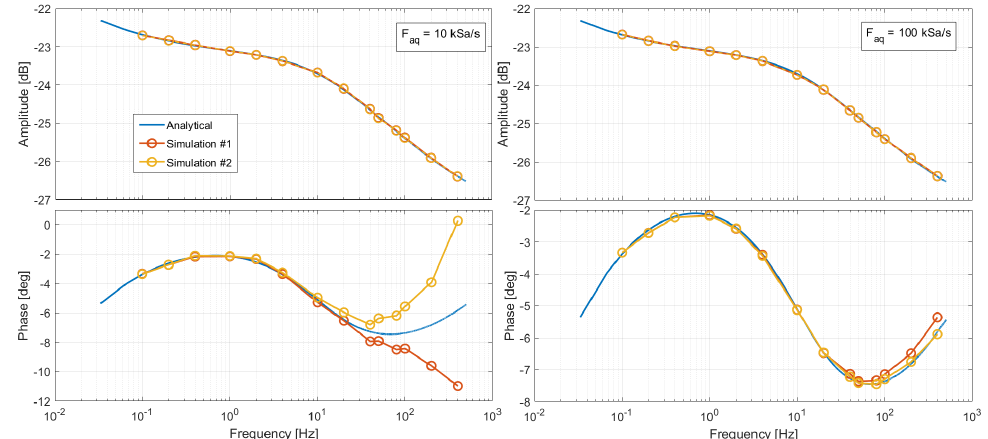
Figure 8. Effects of the non-synchronization of the EIS board with the emulator board. A random delay or anticipation has been inserted between V in and V out in the simulation. ( Left ): Simulation results for amplitude and phase of the FIR frequency response when the sampling period of the EIS board is set to T aq = 100 µ s. ( Right ): Simulation results when T aq = 10 µ